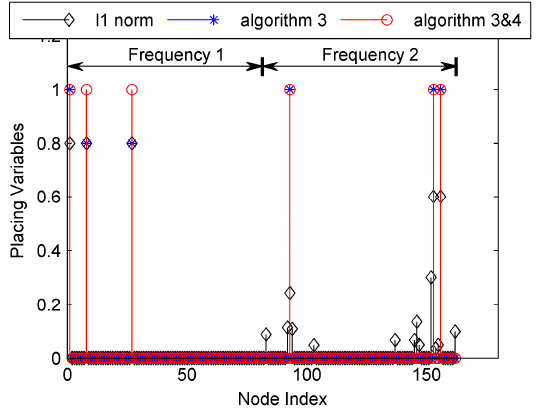
Figure 4. The solutions of (15) using three methods.